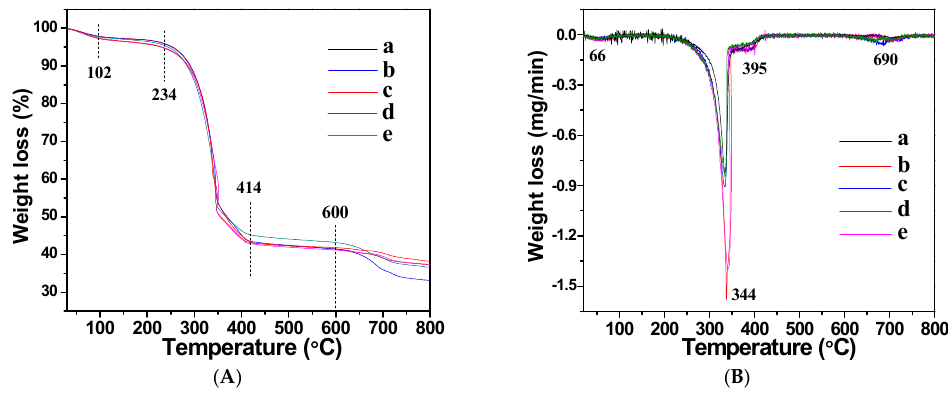
Figure 5. ( A ) Thermogravimetric analysis (TGA) and ( B ) derivative thermogravimetry (DTG) curves